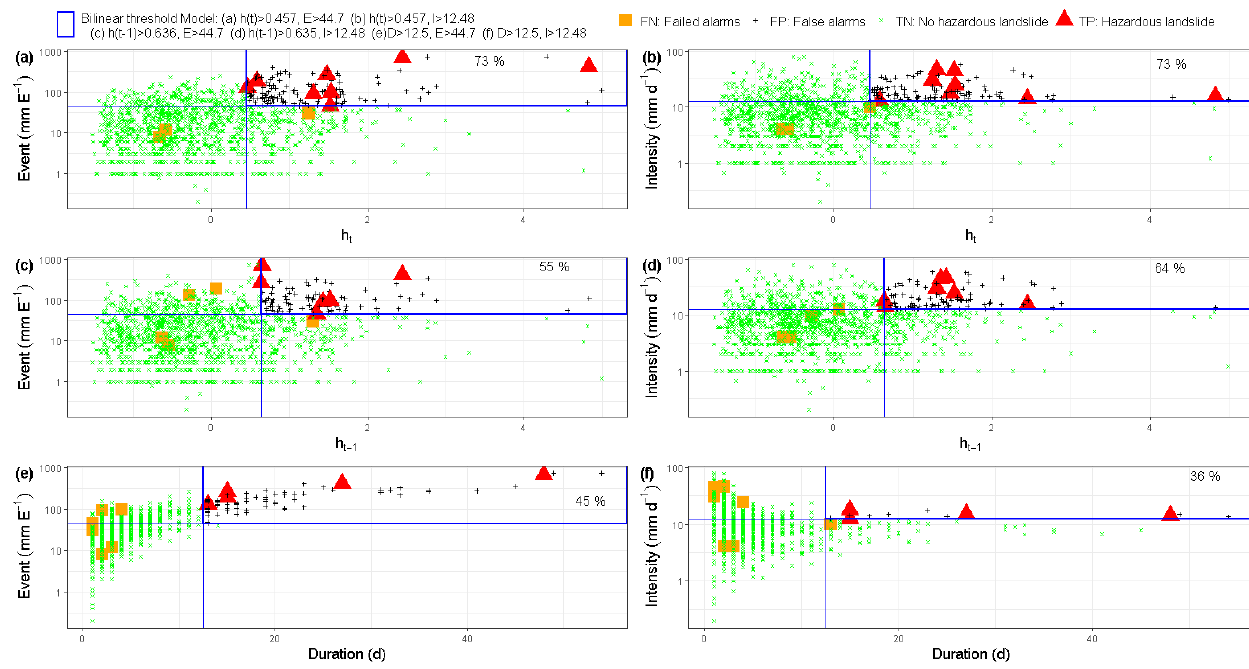
Figure 8. Landslide warning capabilities of the hydro-meteorological and precipitation threshold models: (a) h t – E , (b) h t – I , (c) h t − 1 – E ,